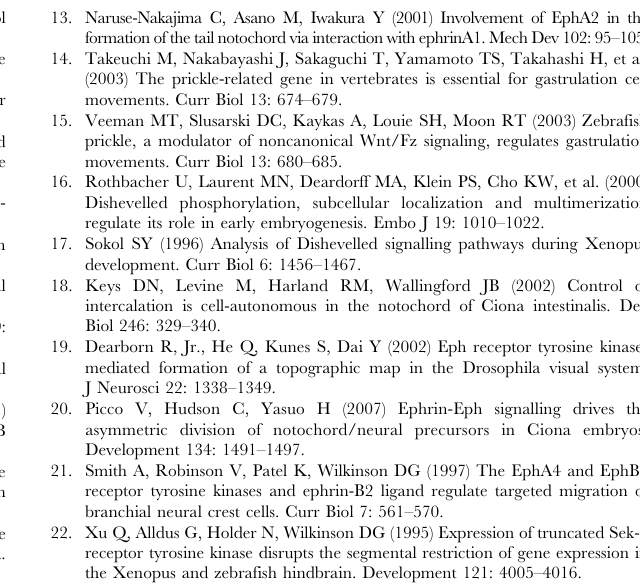
Figure S1 Localization pattern of laminin over the notochord surface detected by using anti-mouse laminin antibody. Embryos at late neurula (A, D), early tailbud (B,E) or middle-late tailbud (C,F) stages double-stained with the anti-mouse laminin (D–F) and with phalloidin (A–C). Images were taken under a convensional optical microscope (A,D) or a confocal microscope (B,C,E,F). White dashes encircle notochord forming region. Accumulation of Laminin at the dorsal side of the notochord is indicated by blank arrowheads in D. Lateral view, anterior is to the left. (G) Western blot analysis with ant-Cs-lam (left) and mouse laminin (right) antibodies. Cs-laminin antibody showed a strong signal over 200 KDa (arrowhead) whereas mouse laminin antibody showed a weak signal at a similar size (open arrowhead) but also showed many other bands. Figure S2 Subcellular distribution of aPKC in notochord cells after cell intercalation process. Confocal sagittal section images of an embryo immunostained for aPKC (red) and stained with phalloidin (green) at the early larva stage (A) or late larva stage (D). A reconstructed cross section image at the level indicated by arrows in A and D is shown in B/C and E/F, respectively. Figure S3 Expression of ephrinAa detected by in situ hybridiza- tion. Late neurula (A) and middle-late tailbud (B) stage embryos. Lateral view, anterior is to the left. Figure S4 Misexpression of Eph4TM or Eph3 D C causes no severe morphological defects in notochord cells. Confocal section